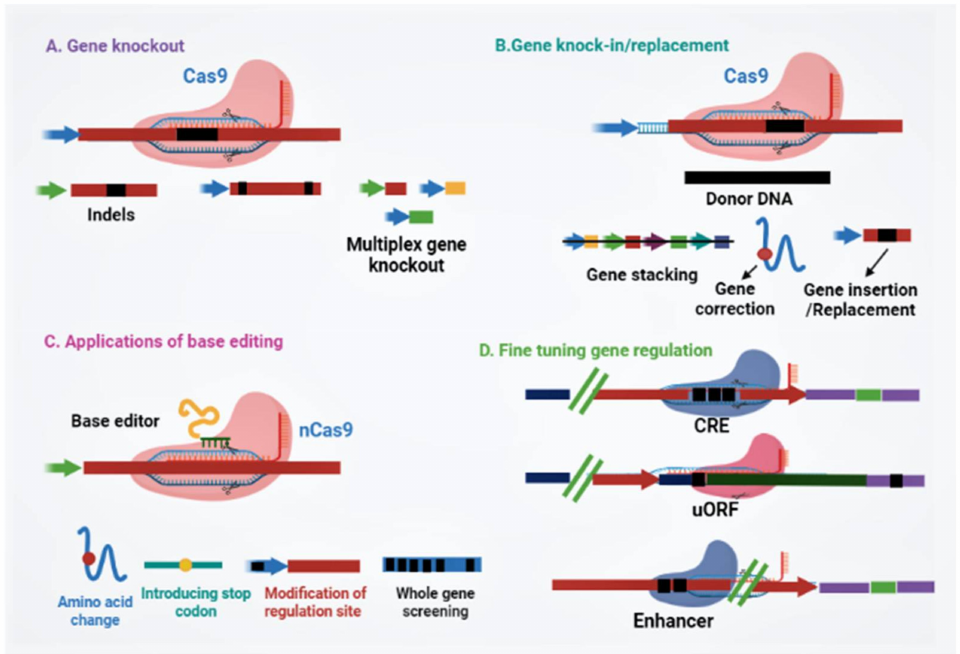
Figure 2. Potential applications of CRISPR/Cas-based applications for plant breeding. ( A ) CRISPR/Cas-mediated mutation can achieve indels, gene deletions, and multiplex gene knockout. ( B ) Gene insertion and replacement mediated by either homology-directed repair or non-homologous end joining can accomplish gene stacking for multiple traits, gene correction for gain-of-function, and gene insertion or replacement to generate novel traits for crop improvement. ( C ) Applications of base editing for crop trait improvement, viz. precise amino acid substitution, gene disruption by introducing a stop codon, gene regulation, and whole-gene screening. ( D ) CRISPR/Cas system-based gene regulation by engineering the regulatory site in the untranslated region, promoter, or enhancer region. Abbreviations: CRE, cis-regulatory element; sgRNA, single guide RNA; uORF, upstream open reading